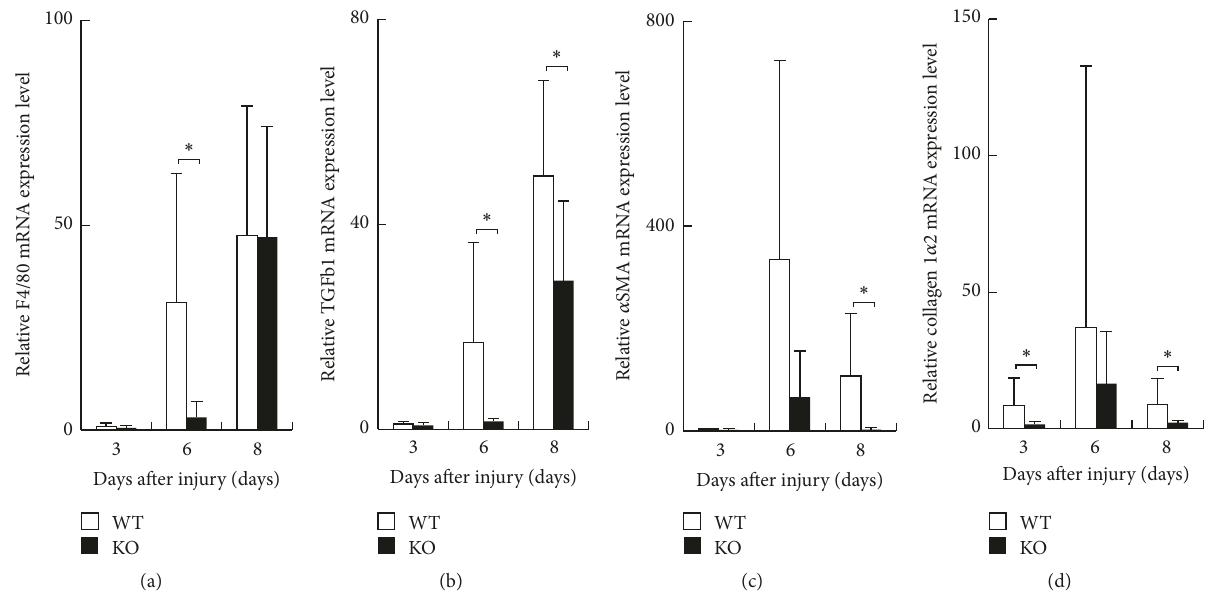
Figure7:ExpressionofmRNAof 𝛼 -smoothmuscleactin( 𝛼 SMA),F4/80,transforminggrowthfactor 𝛽 1(TGF 𝛽 1),andcollagen1 𝛼 2inhealing tissues of wild type (WT) and inducible nitric oxide synthase (iNOS-) knockout (KO) mice at days 3, 6, and 8. (a) F4/80 mRNA expression was significantly more suppressed in KO tissues at day 6 as compared with WT tissues. (b) Expression of TGF 𝛽 1 mRNA was significantly attenuated in KO tissues as compared with WT tissues at days 6 and 8. (c) Expression of 𝛼 SMA mRNA was significantly less marked in KO tissues at day 8 as compared with WT tissues. (d) Collagen 1 𝛼 2 mRNA expression was reduced in KO tissues as compared with WT tissues at days 3 and 8 with statistically significant difference. Open bars: WT, filled bars: KO. Mean ± standard deviation. ∗ 𝑝 < 0.05 ; n.s., not